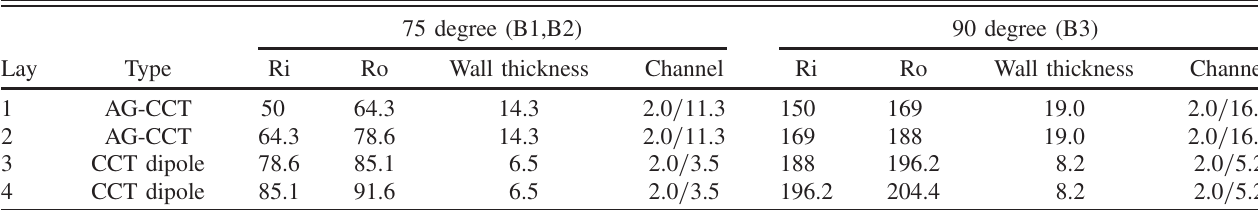
TABLE V. Winding Mandrel geometry (in